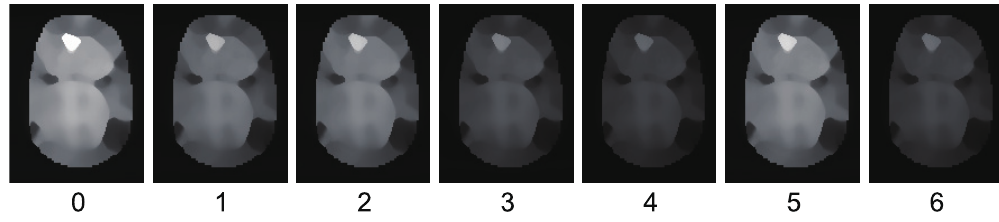
Figure 17. The results for owl object, which only causes diffuse reflection. Estimated albedo is shown, which is smooth enough.